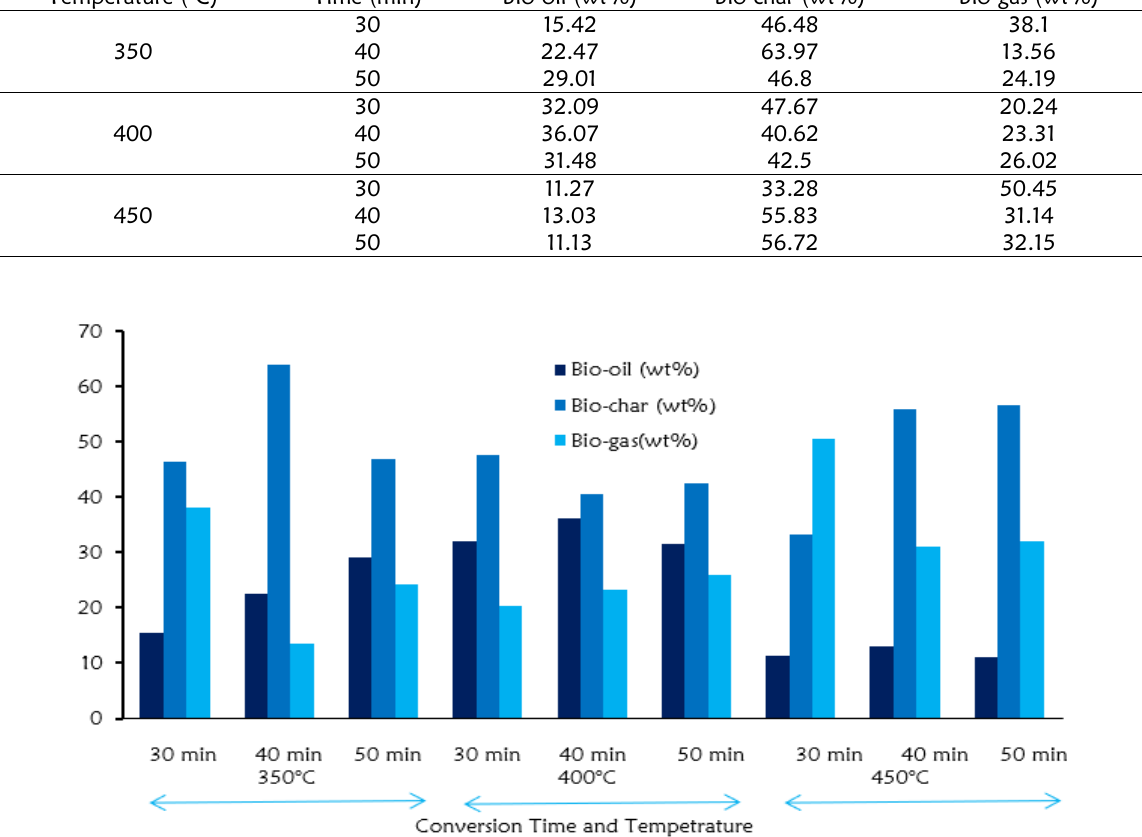
Figure 5: Overall product yield of conventional heating